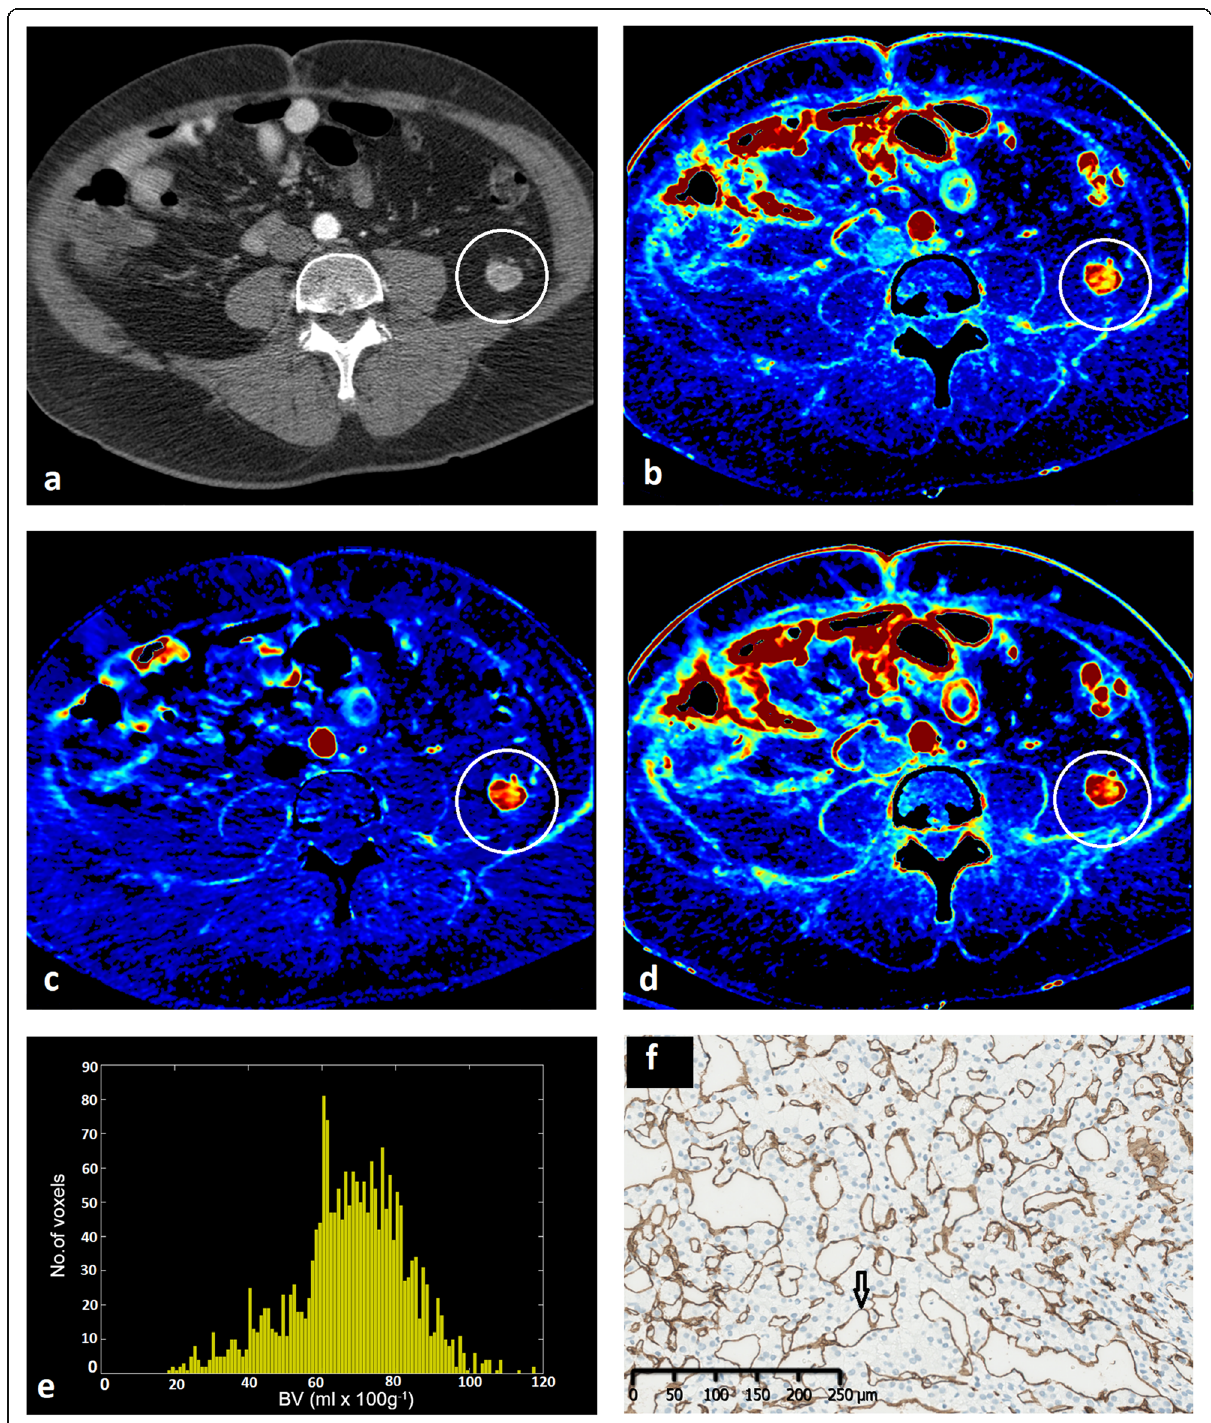
Fig. 2 A retroperitoneal metastasis marked with a white circle depicted on (a) a contrast-enhanced CT at peak arterial enhancement with the corresponding functional imaging colour maps, (b) BV deconv , (c) BV Patlak , and (d) BF deconv . BV deconv histogram for the entire target lesion at baseline is shown in e , while f represents the CD34 immunostaining from the same retroperitoneal metastasis with microvessels (arrow) stained brown. BV deconv Blood volume (deconvolution), BV Patlak Blood volume (Patlak), BF deconv Blood flow